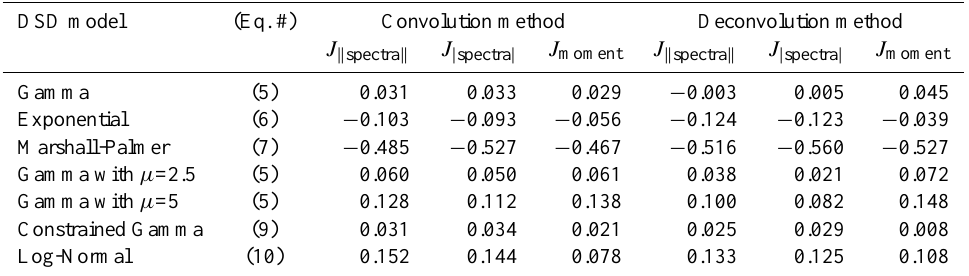
Table 2. Bias of D m for each DSD estimate relative to the ensemble mean (see Eq. 22). Each row corresponds to a DSD model (described in Sect. 2) with the model equation shown in the parentheses. Each column corresponds to a numerical inverse method (described in Sect. 4) and a cost function (described in Sect.